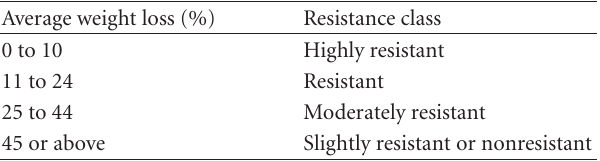
Table 3: Decay resistance class (ASTM D2017-81, 1986